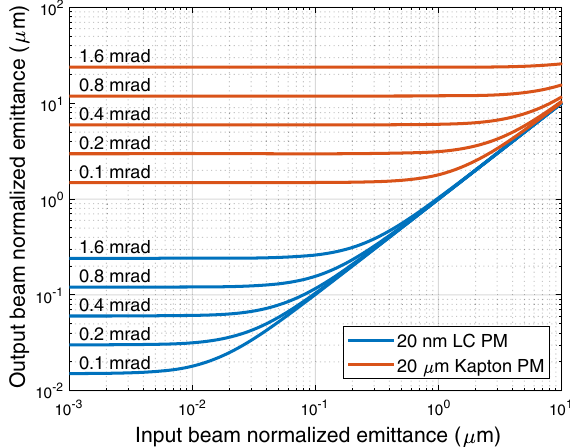
FIG. 4. Graph of normalized emittance after transmission through a plasma mirror as a function of initial normalized emittance. All curves are calculated using the method described in Ref. [6]. The effect of scattering through two different types of plasma mirror (20 nm LC and 20 μ m Kapton) is compared for five discrete initial divergence values. Initial divergence is labeled on each